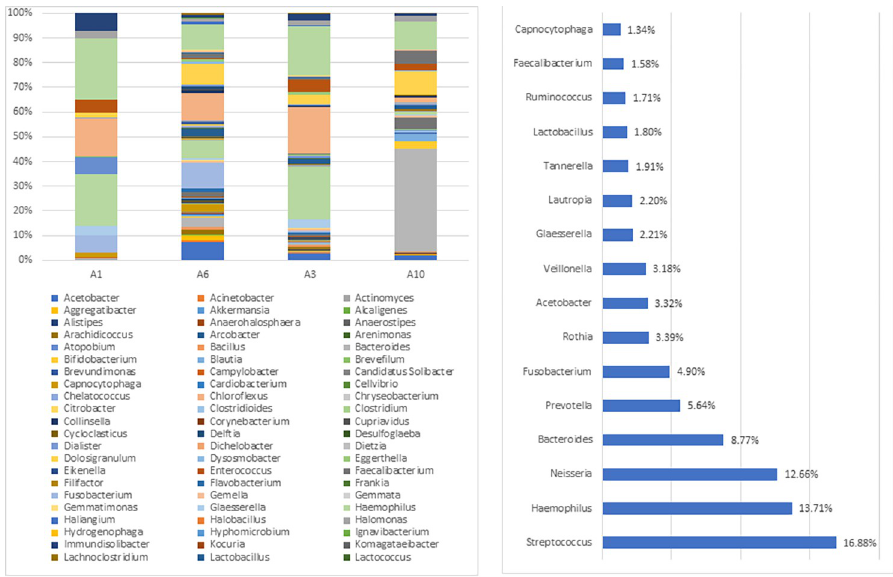
Fig 3. a. Genus-level oral microbiome composition of Occasional: 119 genera including Streptococcus (16%), Haemophilus (13%), Neisseria (12%), Bacteroides (8%), and Prevotella (5%); b. Abundant genera detected in the Betel quid Occasional chewer individuals (excluding genera with less than 1% of relative abundance).